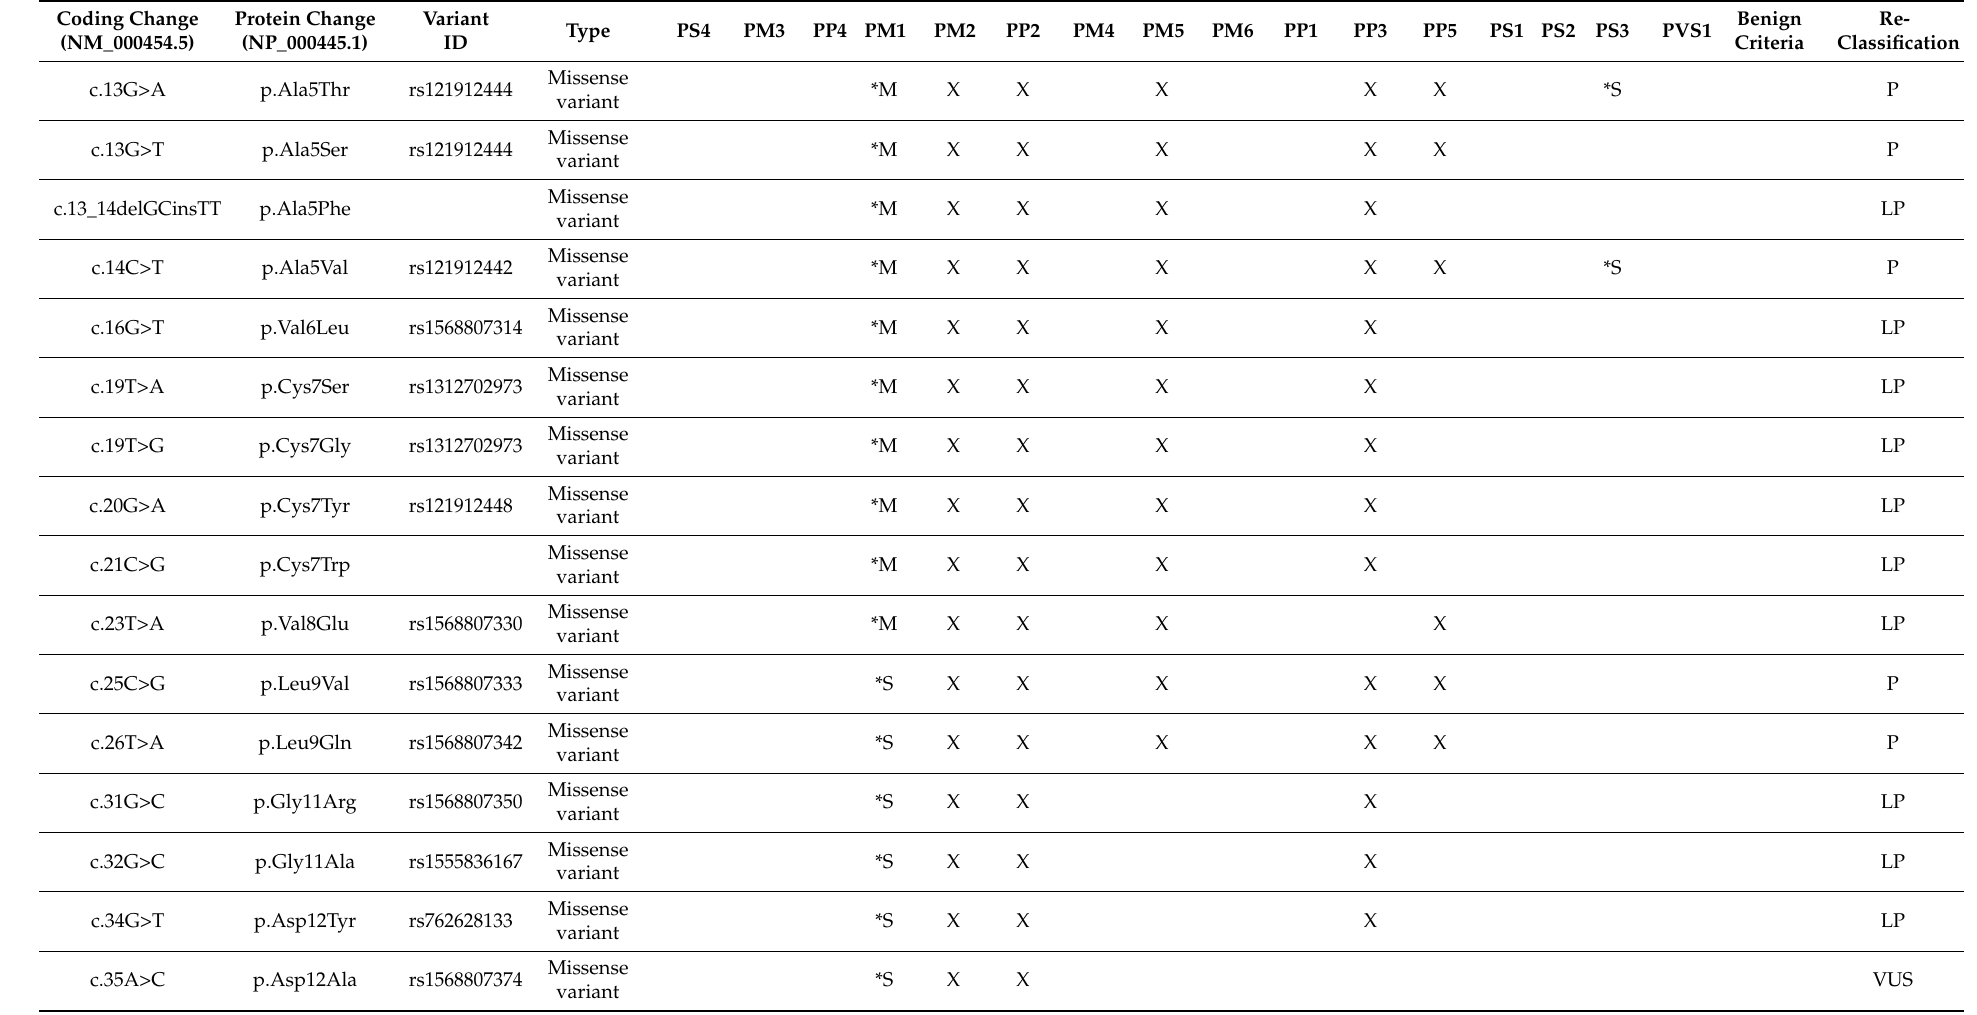
Table 1. SOD1 variants in Amyotrophic Lateral Sclerosis: Systematic re-evaluation according to ACMG-AMP guidelines. Coding Change